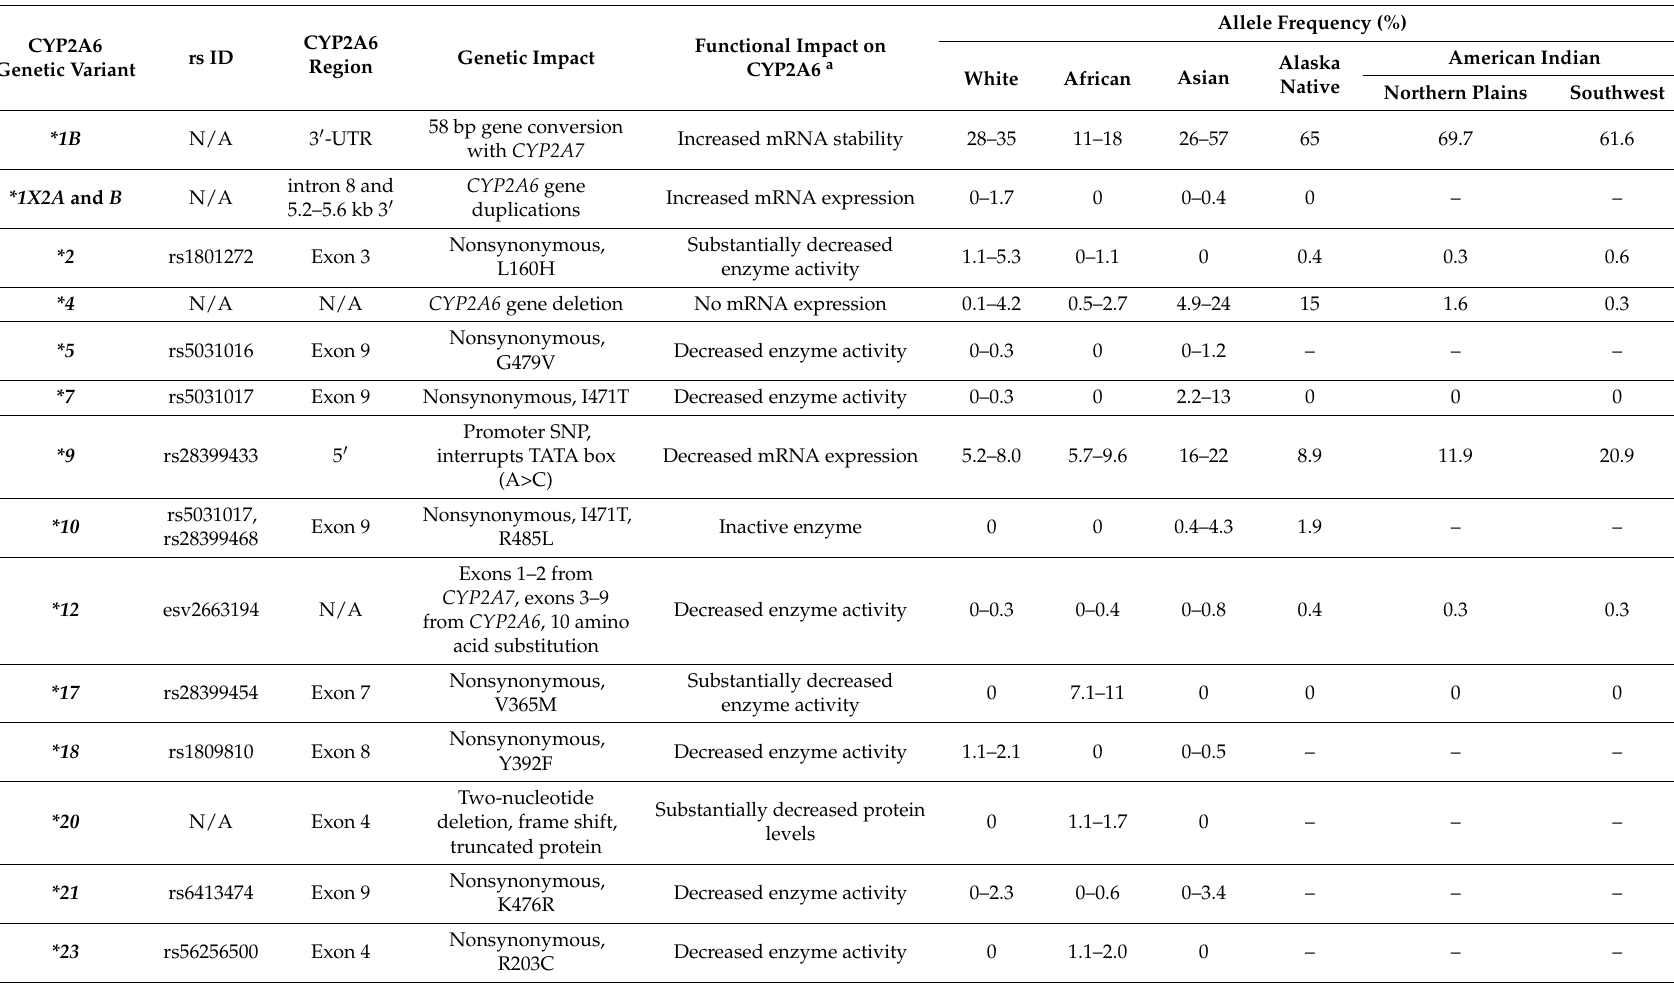
Table 1. Summary of CYP2A6 genetic variants (minor allele frequency (MAF) > 1%, functionally significant variants only) and their impact on CYP2A6 expression and activity (nicotine metabolism) b